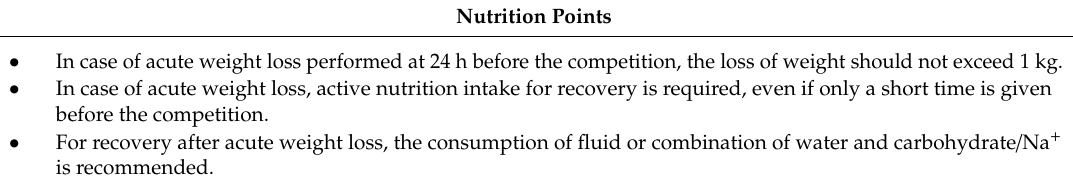
Table 4. Nutrition points for recovery after acute weight loss of lightweight rowing athletes. Nutrition